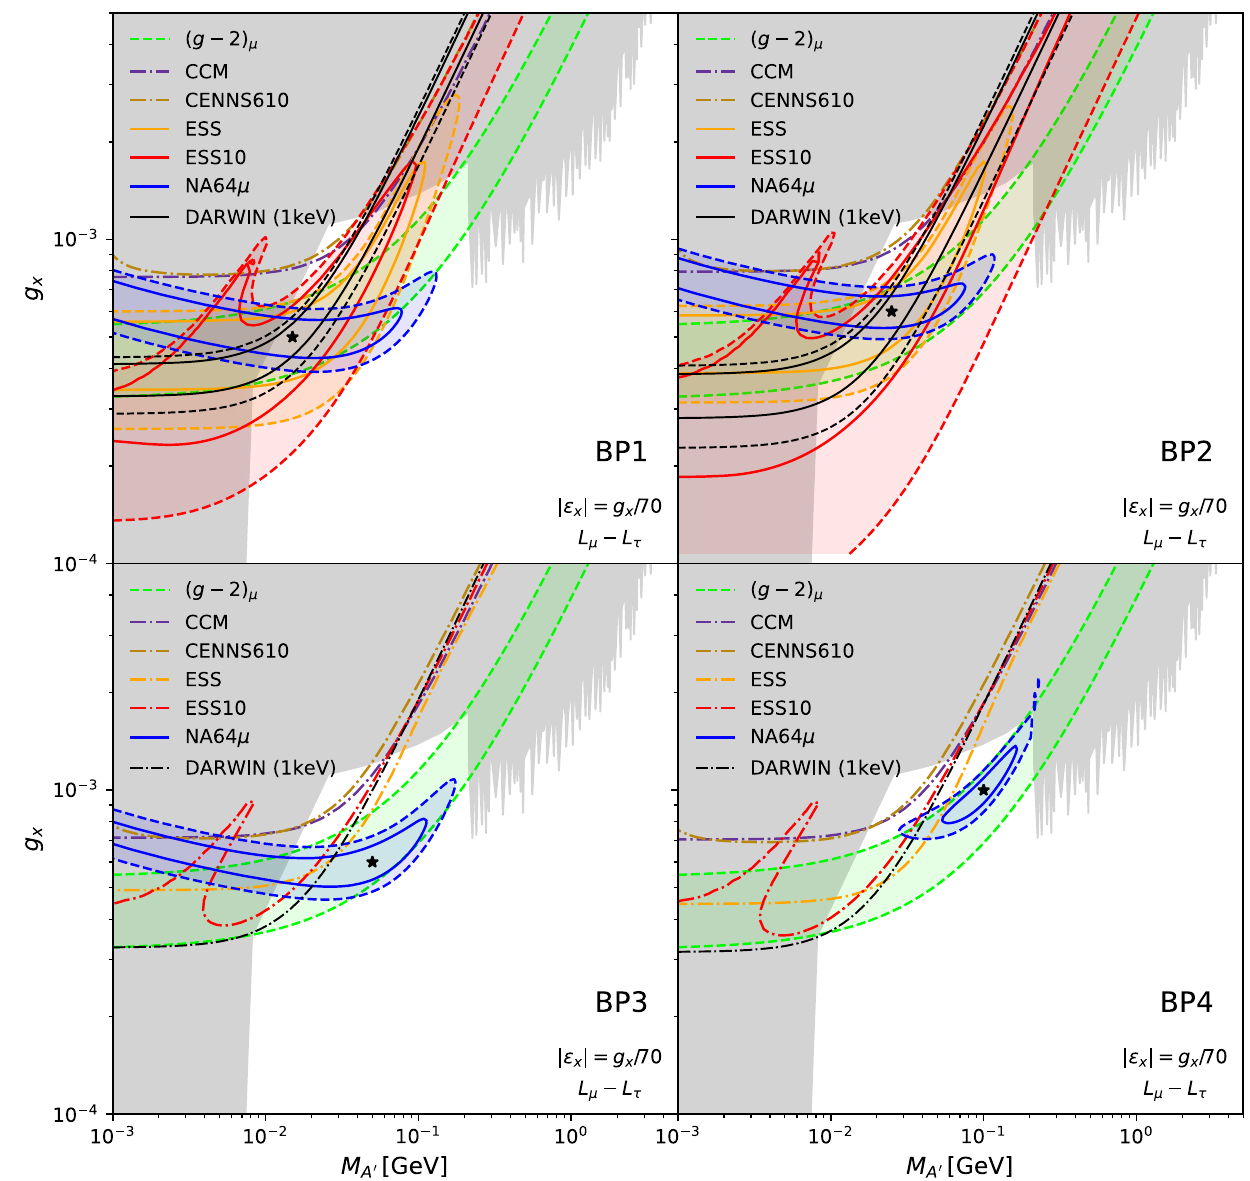
Fig. 12 ParameterreconstructionforeachoftheBPsofTable1assum- ing a U ( 1 ) L μ − L τ model. We use direct detection data from a hypotheti- callow-thresholdsearch( E th = 1keV)inthefutureDARWINdetector. For BP1, the black solid (dashed) contours correspond to the 68% CL